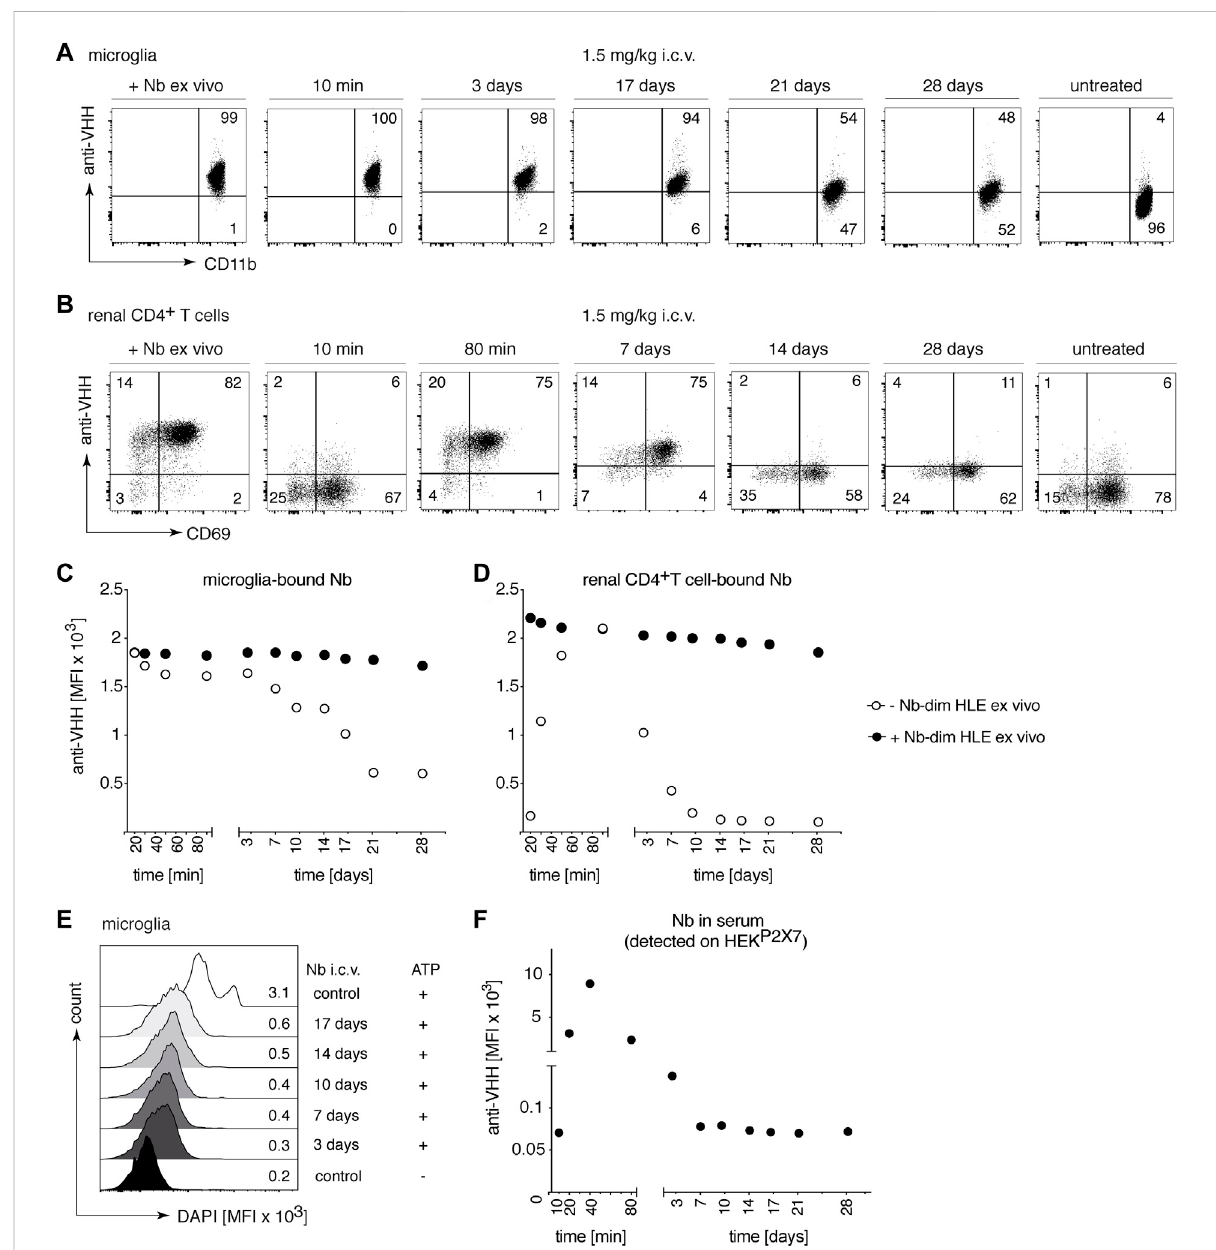
Long-term occupancy and blocking of P2X7 on microglia are achieved after a single i.c.v. injection of a low dose of P2X7 nanobody. Mice were injected i.c.v. with 1.5 mg/kg 1c81 s -dim HLE in 2 μ l volume. At the indicated time points, the occupancy of P2X7 by the nanobody was analyzed on microglia and kidney-resident helper T cells (T RMs ), as described in Figure 2. Flow cytometry dot plots of microglia (A) or renal CD4 + T cells (B) illustratetherelativeoccupancyofP2X7achievedattheindicatedtimepointsafteri.c.v.injectionofnanobodies versusthemaximaloccupancy achieved after exvivo addition ofsaturatingnanobodies (+Nb exvivo ).Graphs displaythetime-dependent MFIofP2X7stainingon microglia (C) and renal CD4 + T cells (D) obtained by i.c.v. injection of nanobodies (open circles); closed circles = maximal staining obtained after ex vivo addition